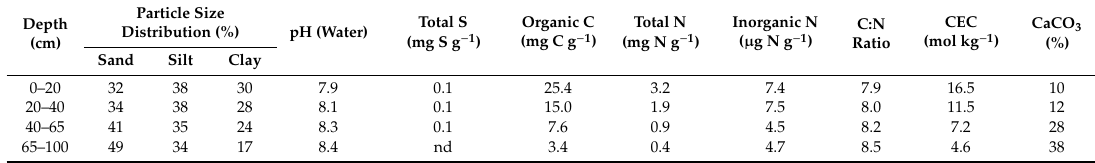
Table 1. Physical and chemical characteristics of the soil in the lysimeters. nd: non-detected value. Particle Size Depth Distribution (cm)